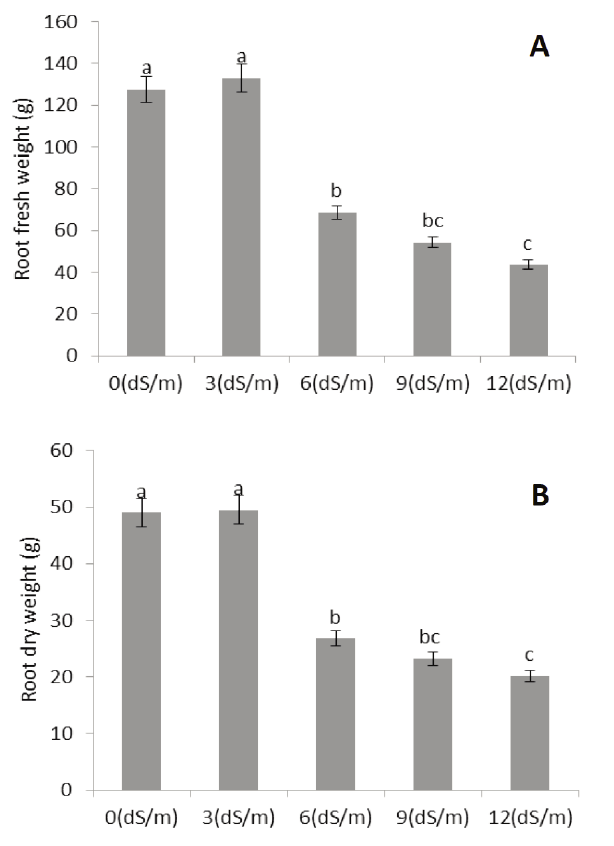
Fig. 1 ­ Effects of different levels of water salinity on fresh (A) and dry (B) weight of root in pomegranate